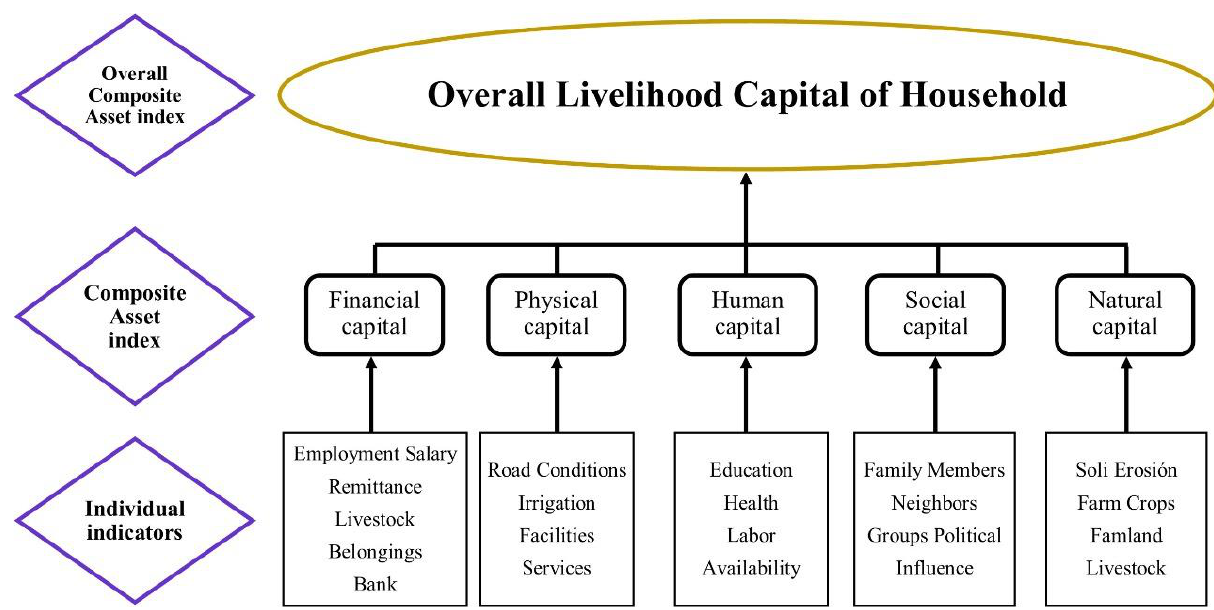
Figure 2. SLA-modified